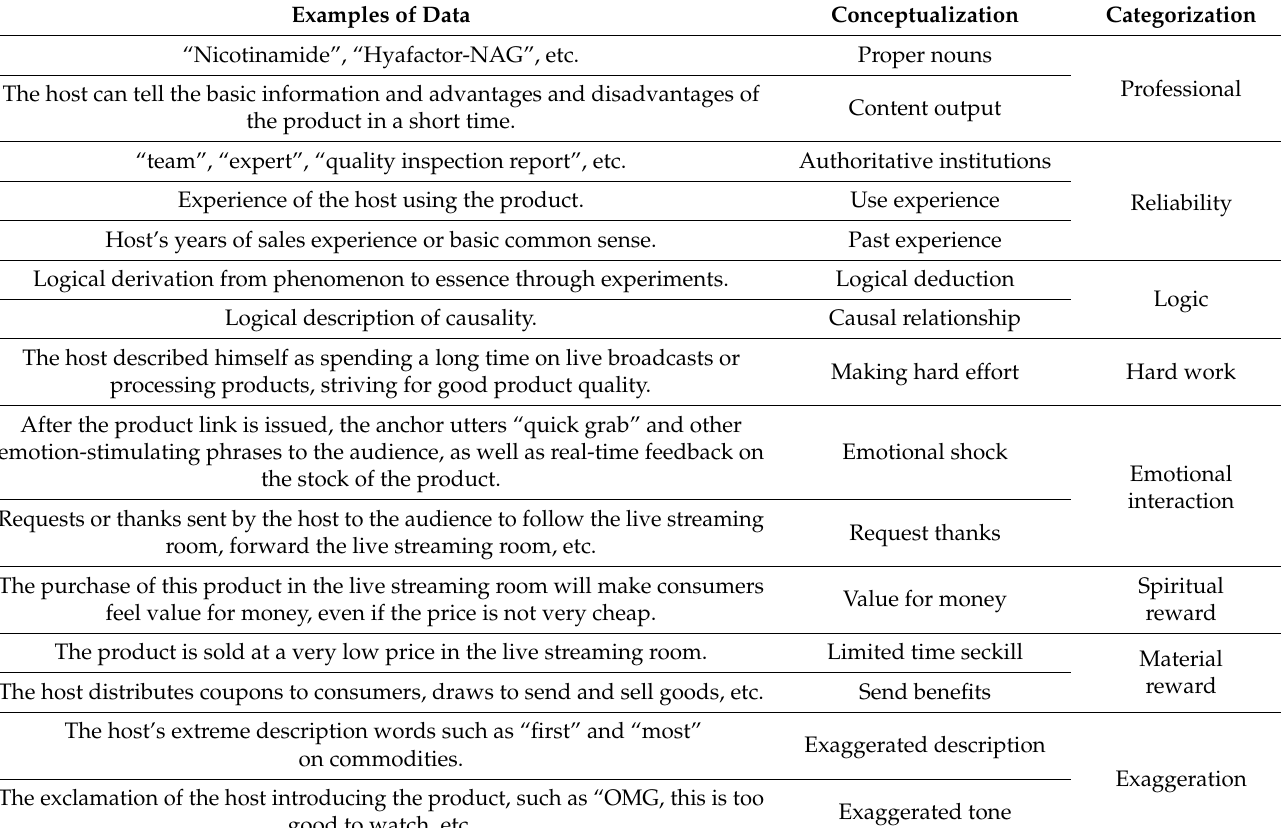
Table 3. Open coding